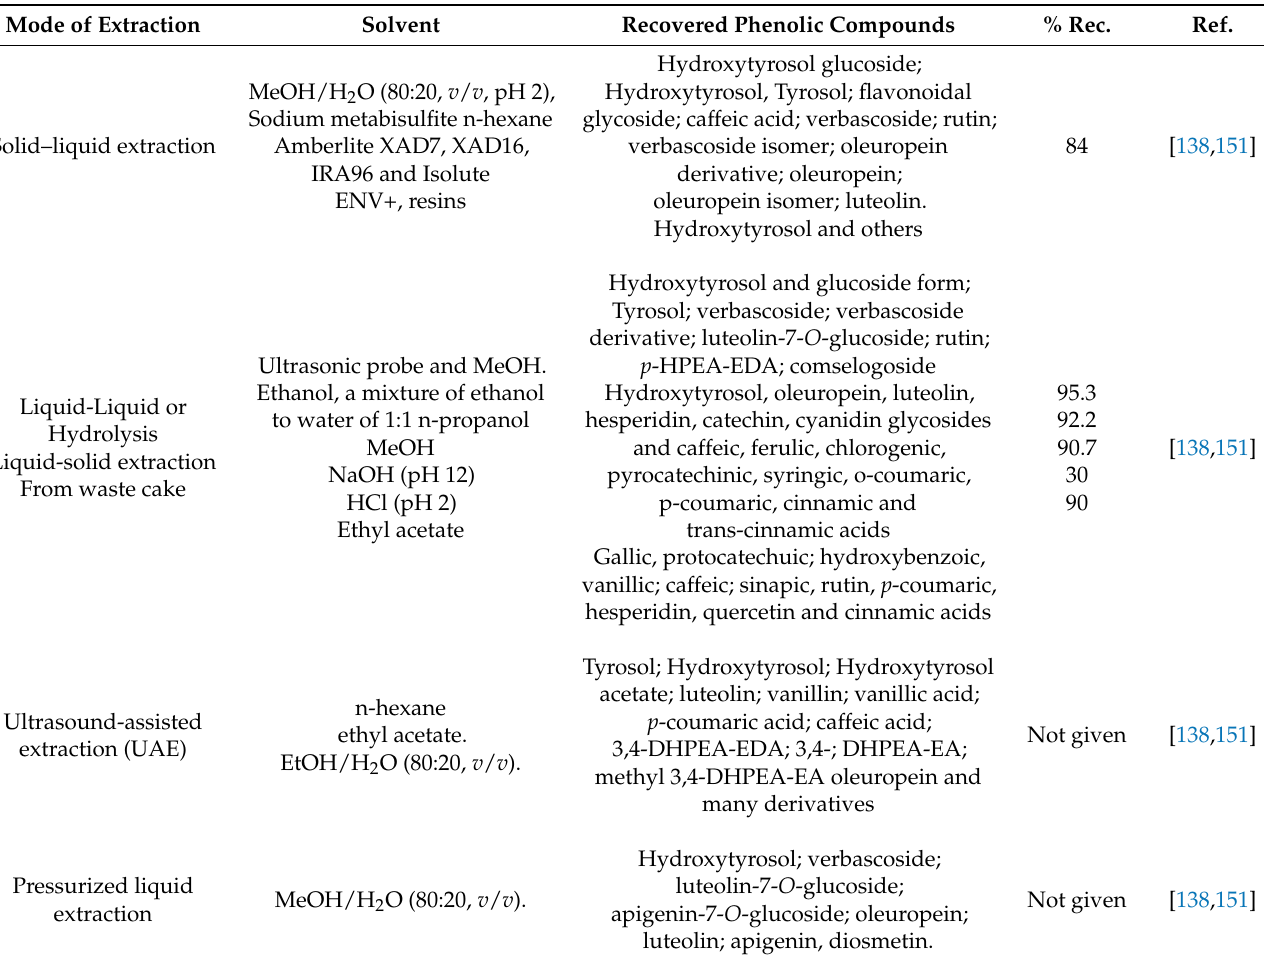
Table 9. Methods for phenolic compounds extraction in olive pomace [193–196]. Recovered Phenolic Compounds % Rec.